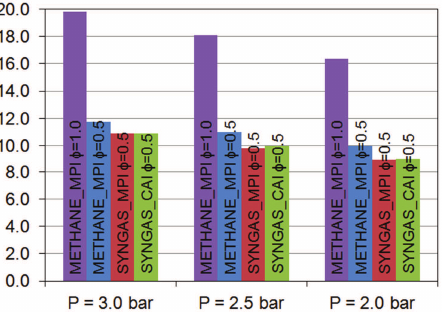
Fig. 14. Results of IMEP for final operating points